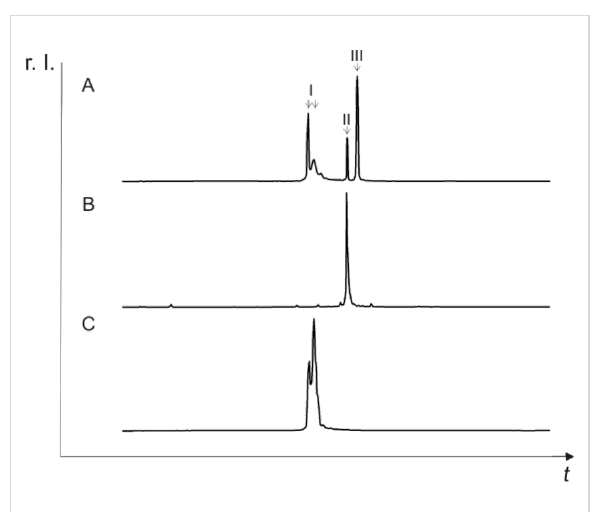
Figure 8: Reversed-phase HPLC analysis. A: Crude product of the coupling reaction between the 20mer model RNA and 1. The peaks I correspond to the periodate oxidized and subsequently reduced RNA. Peak II matches the cytidine derivative 1 . Peak III indicates